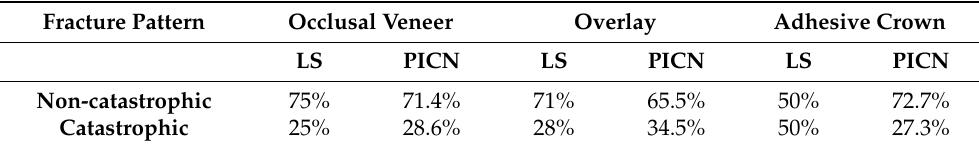
Table 4. Failure modalities of the observed specimens.